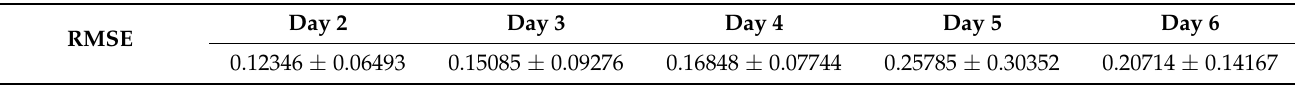
Table 2. The average root-mean-square error of the ECG from day 2 to day 6 with respect to the ECG of day 1. RMSE